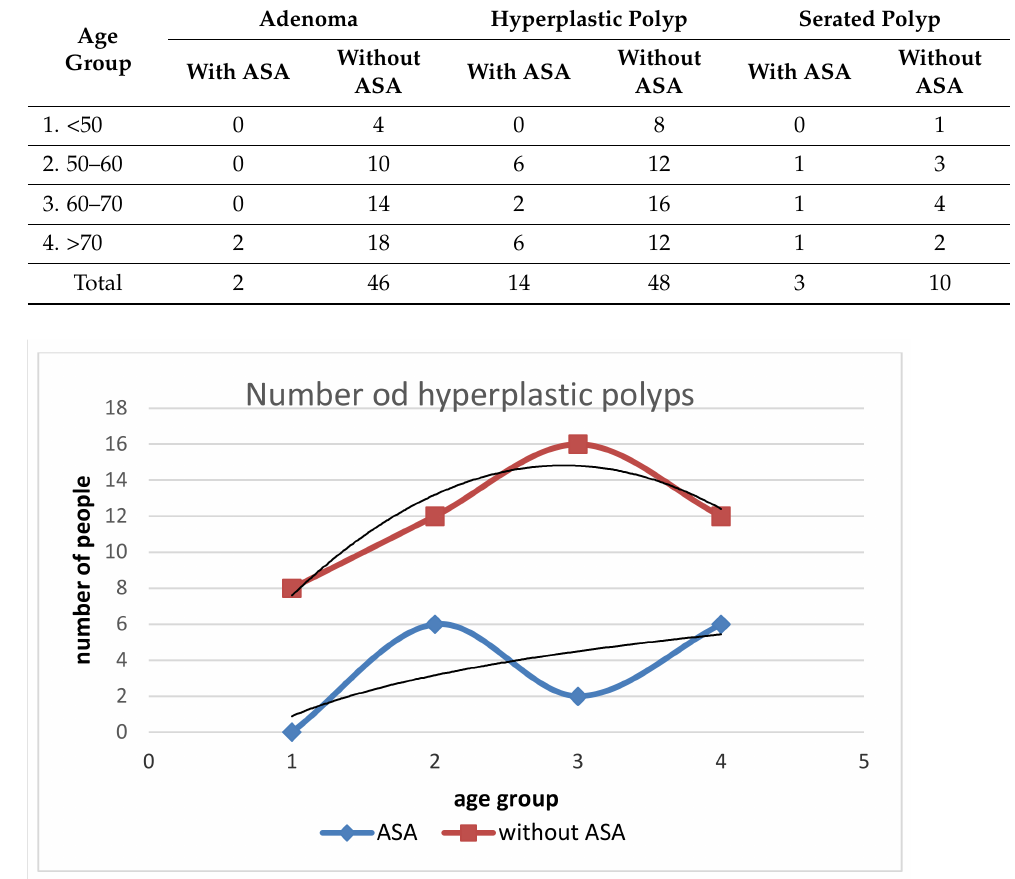
Figure 7. Relationship of hyperplastic polyp incidence in people with ASA and without ASA by age groups. The number of hyperplastic polyps in people without ASA increases between the ages of 50–70 years and then decreases. The rate of growth of hyperplastic polyps in people without ASA decreases with age. In people taking ASA, the number of hyperplastic polyps increases in the age group of 50–60 years and then decreases to take an increasing trend again from the age of 70 years. The trend of decreasing rate of growth of these polyps is similar to that in people without